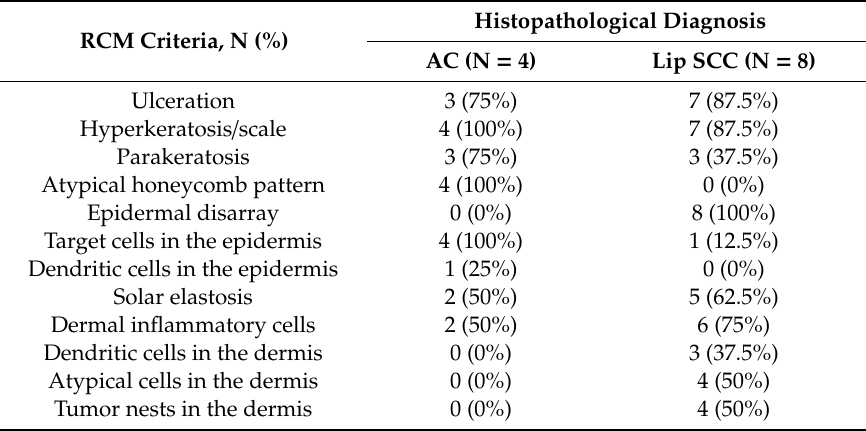
Table 3. Frequencies of RCM criteria for AC and lip SCC.